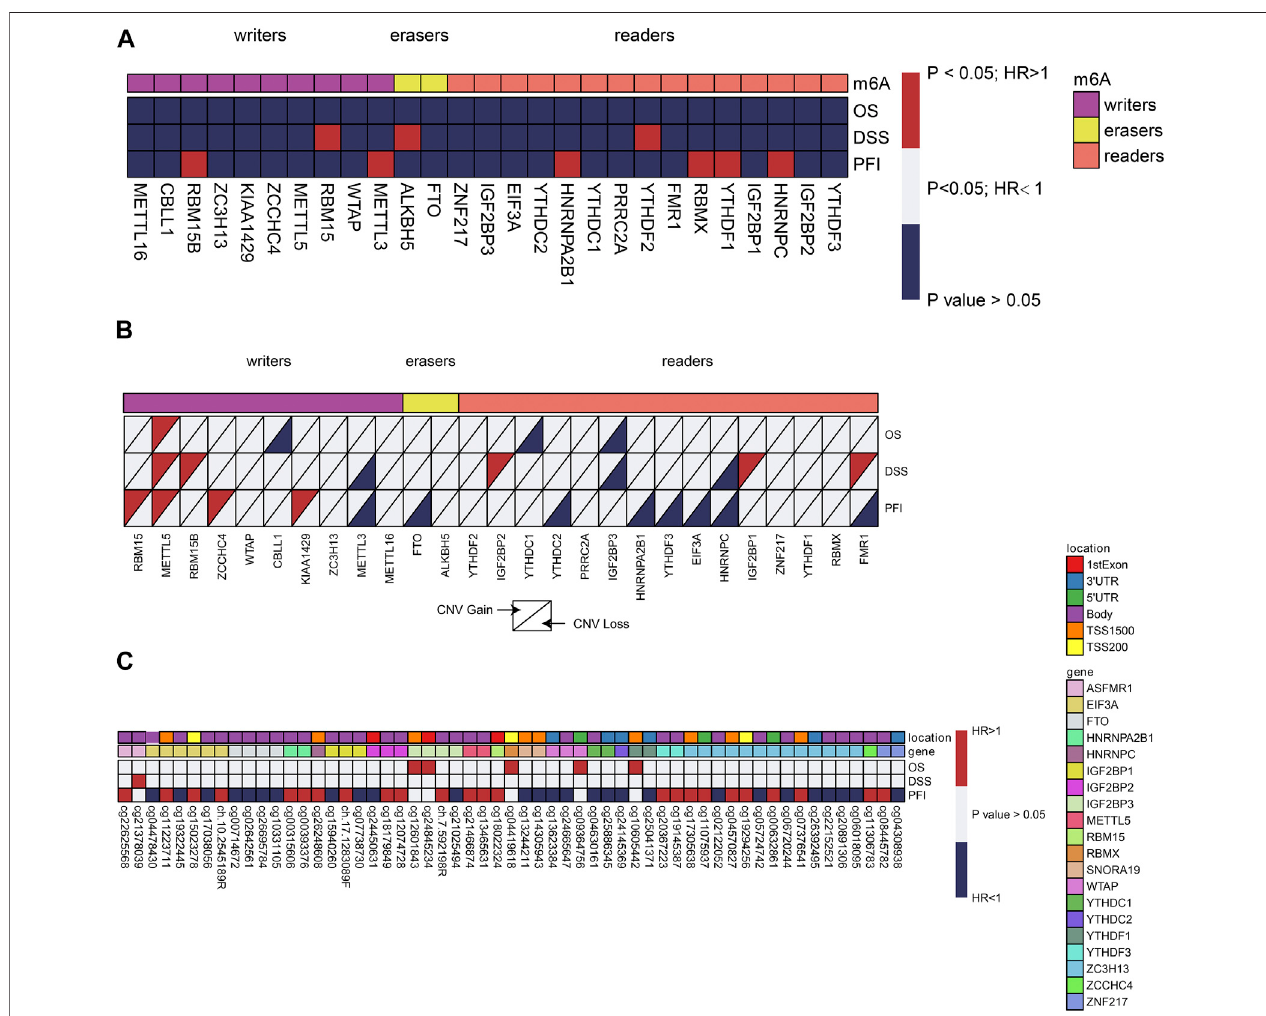
FIGURE2| Univariatecoxregressionanalysisofm6Aregulators. (A – C) Univariatecoxregressionanalysisoftheassociationbetweenoverallsurvival(OS),disease- free survival (DFS), or progression-free survival (PFS) and gene expressions. Blue box, protective factors (HR < 1 and p < 0.05); Red box, risky factors (HR > 1 and p < 0.05); white box, p > 0.05. The sample size used in each cox regression analysis was marked in brackets.